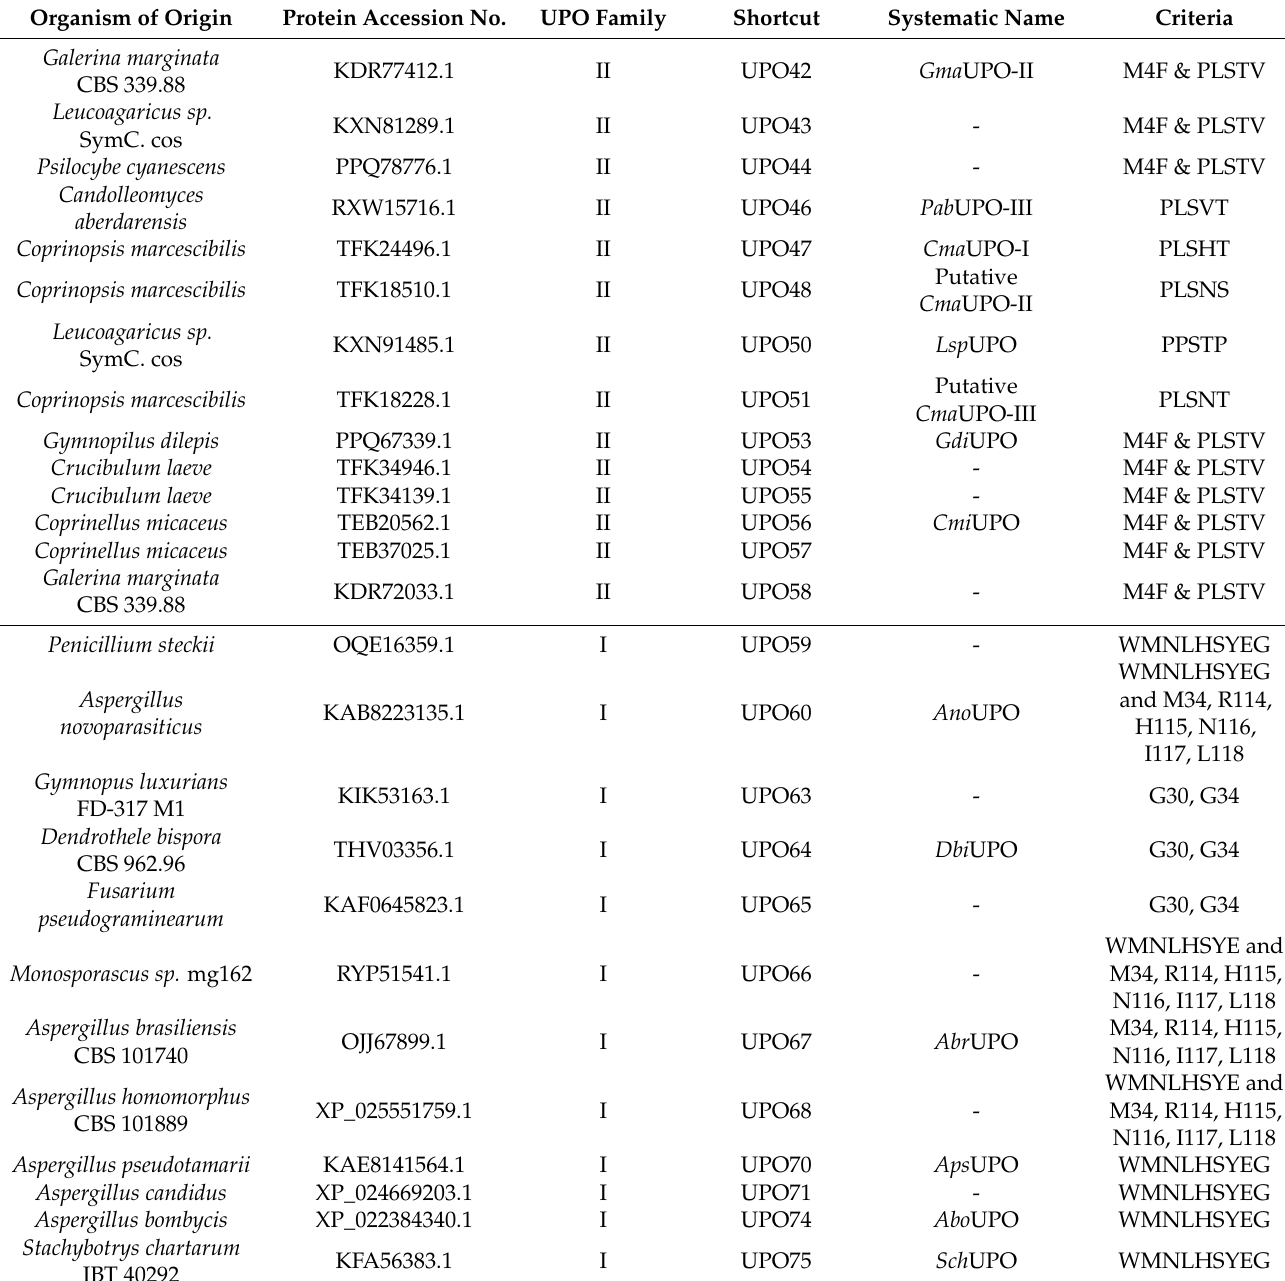
Table 3. Summary of UPO target